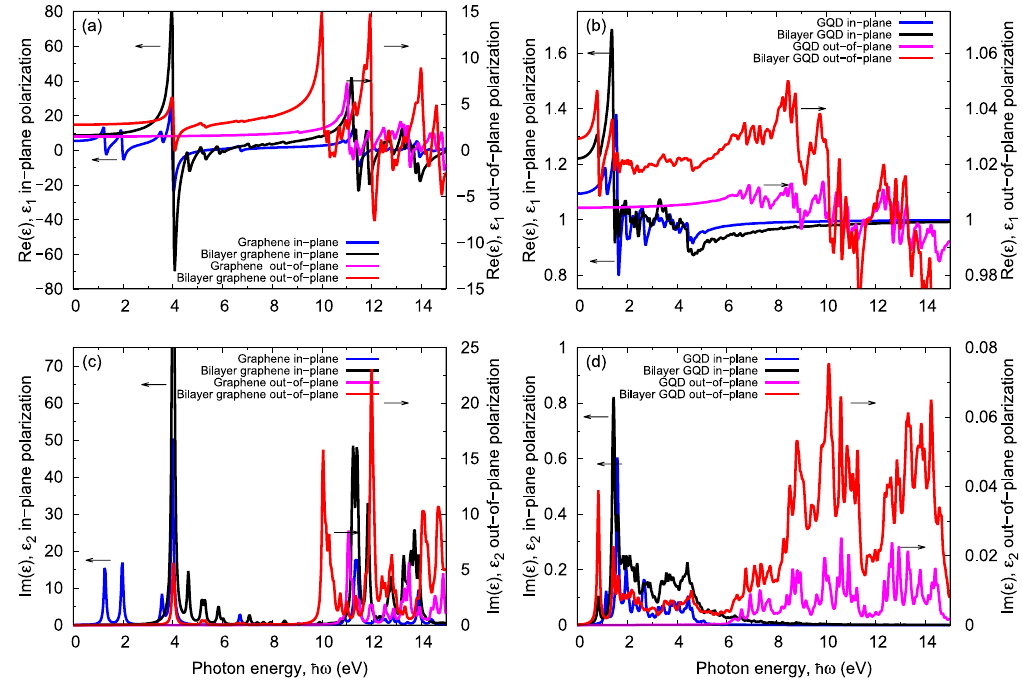
Figure 5. Spectra of the dielectric coefficients (epsilon) of monolayer and bilayer systems for various incident light polarizations: ( a ) the real part of epsilon for the graphene sheet, ( b ) the real part of epsilon for the ABhexC 132 H 40 GQD, ( c ) the imaginary part of epsilon for the graphene sheet, and ( d ) the imaginary part of epsilon for the ABhexC 132 H 40 GQD.